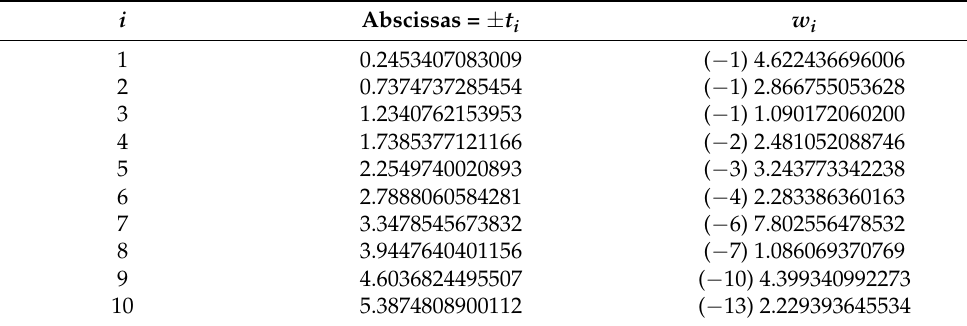
Table 1. Table of abscissas and weight factors for Gauss–Hermite